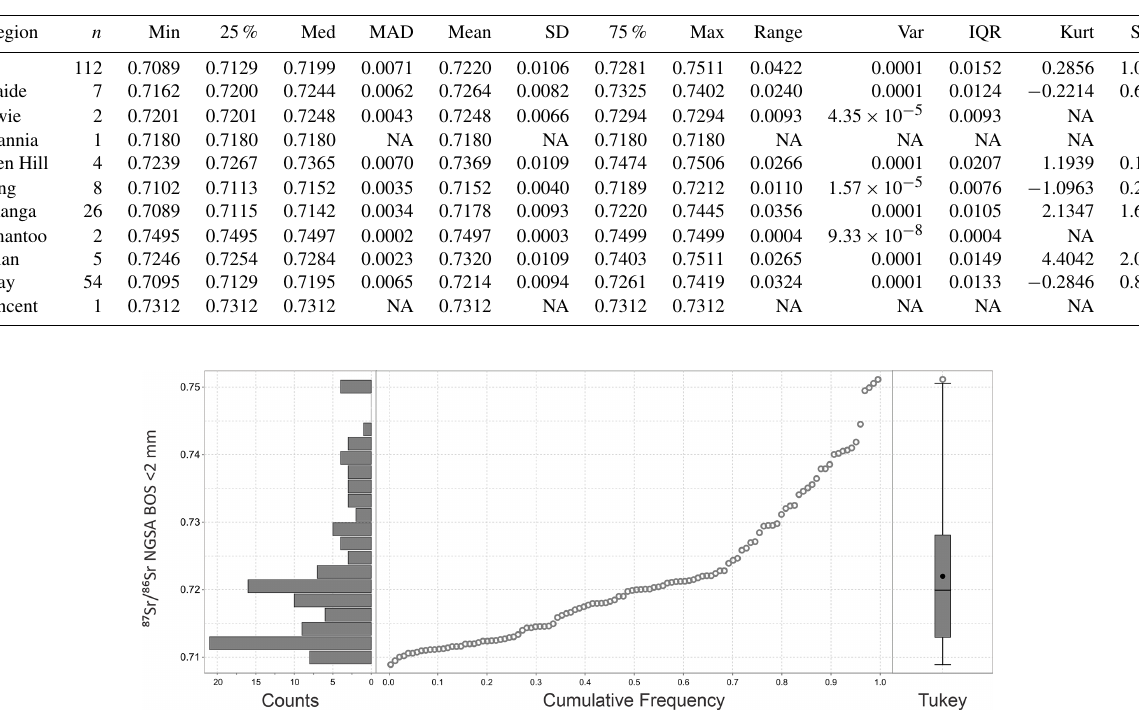
Figure 3. Univariate distribution of the 87 Sr / 86 Sr data from the Darling–Curnamona–Delamerian (DCD) Sr isotope study area: (left) his- togram (20 bins 0.002 wide); (middle) cumulative frequency plot; and (right) Tukey boxplot (mean = black